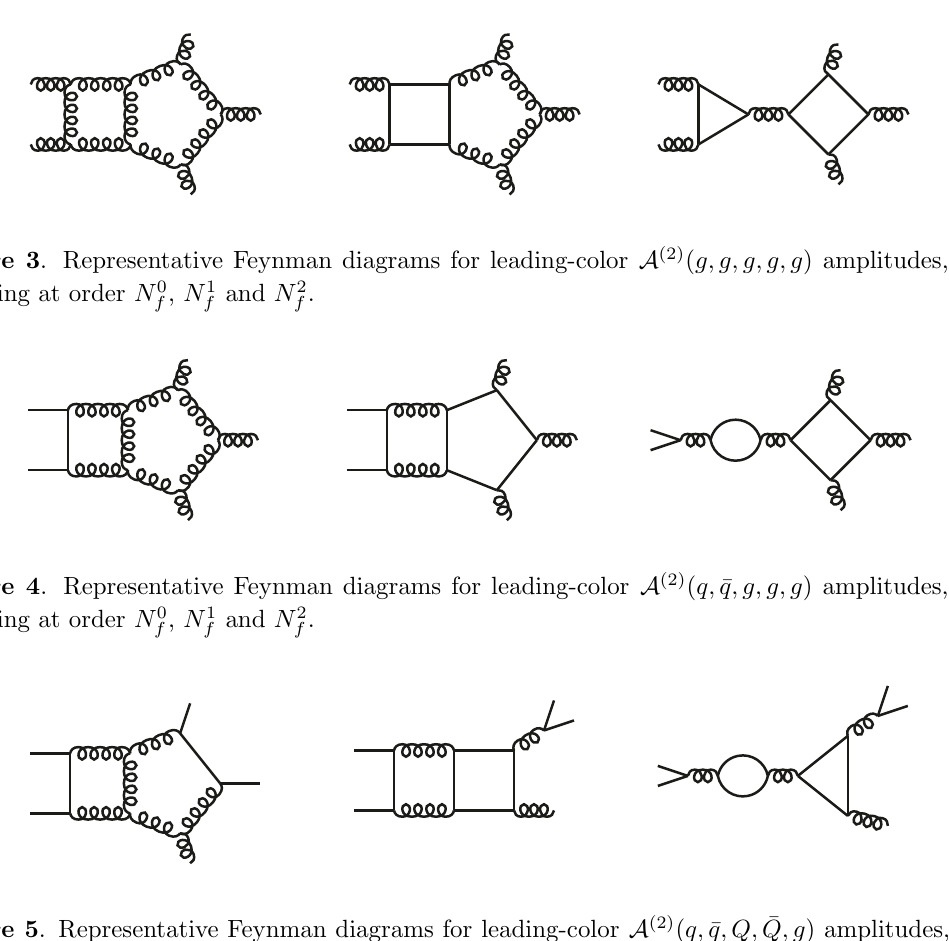
, N 1 and N 2 f f f